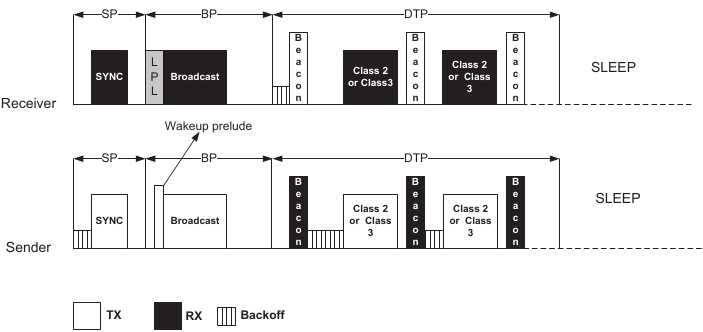
Figure 3. Medium access and packet transmission in